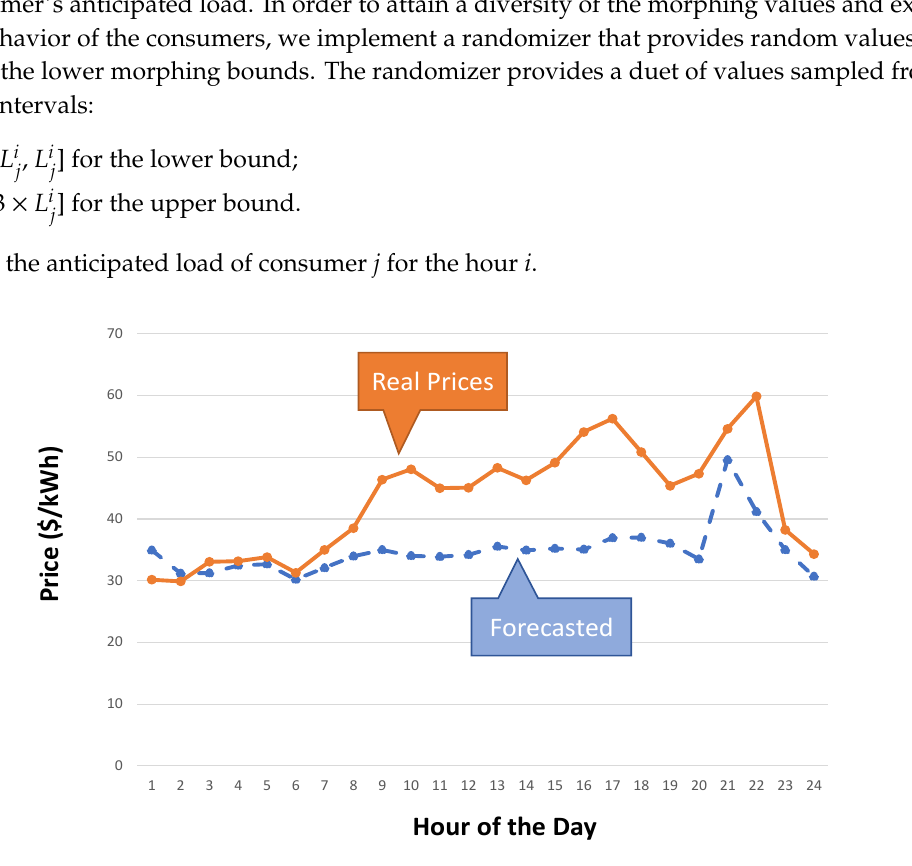
Figure 4. Real and forecasted price signal utilized for cost objective.